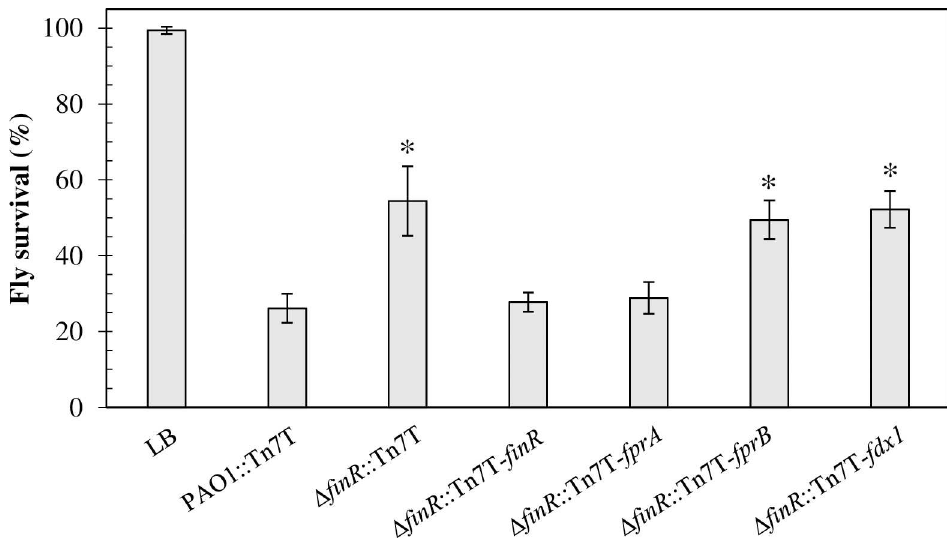
Fig 6. Virulence of P . aeruginosa strains. The virulenceof PAO1 containing the Tn7T vector control (PAO1::Tn7T) and Δ finR mutants containing Tn7T, Tn7T- finR , Tn7T- fprA , Tn7T- fprB , or Tn7T- fdx1 were determined using the Drosophila melanogaster feedingmethod. The percent fly survival was scored after 18 hours of incubation.Data presented are means ± SD of three independentexperiments. The asterisk indicatesstatistically significantdifference (p < 0.01) comparedwith PAO1::Tn7T. LB representsfeedingthe flies with LB